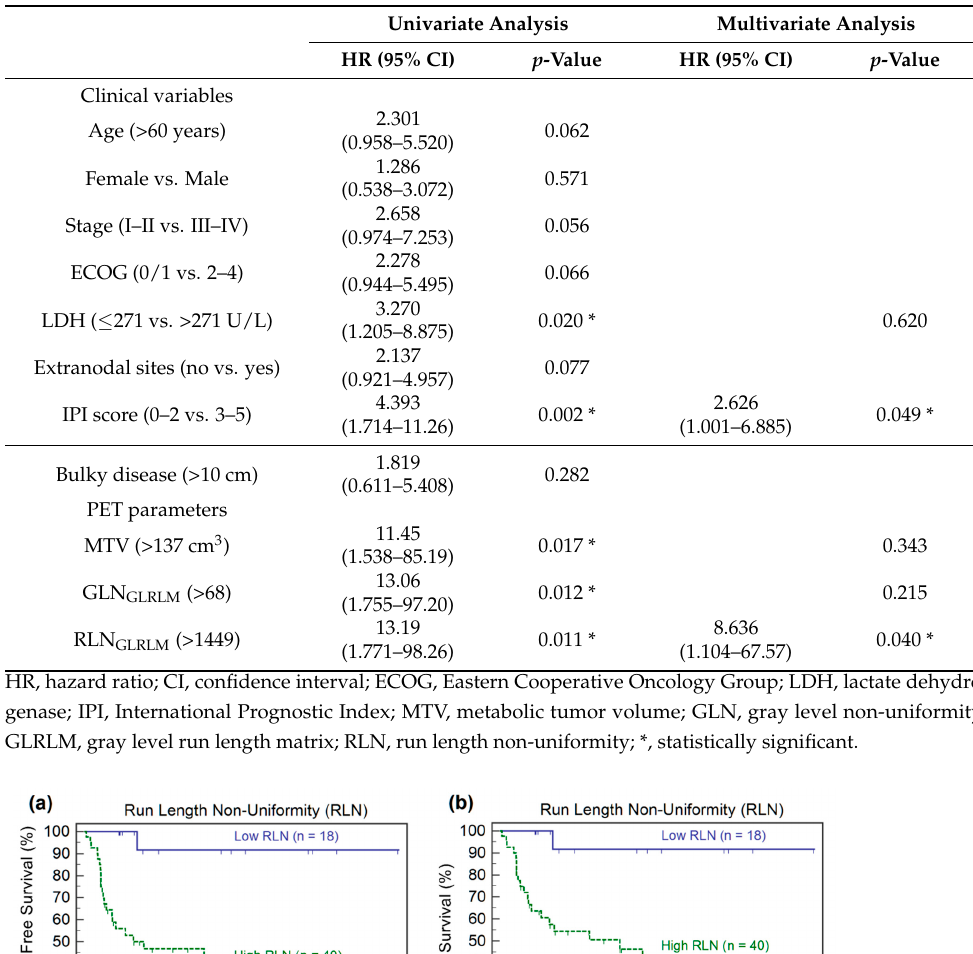
Table 3. Univariate and Multivariate Analyses for Prognostic Factors of Overall Survival.